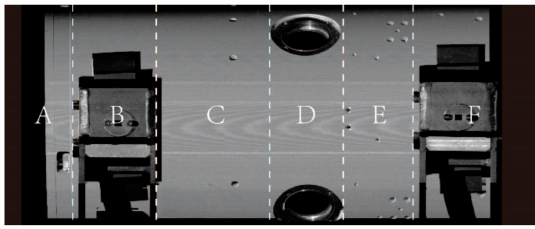
Figure 11. A referenced side view of the cylindrical